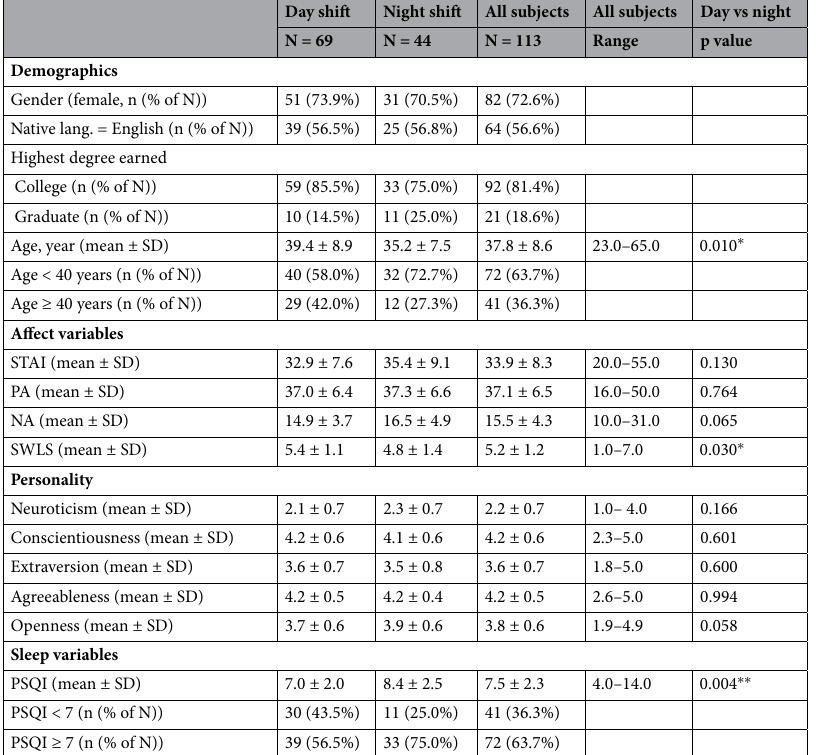
Table 1. Demographic information and behavioral variables for both day and night shift nurses. STAI: state trait anxiety; PANAS: positive and negative affect schedule; SWLS: life satisfaction; BFI-2: big five inventory-2;